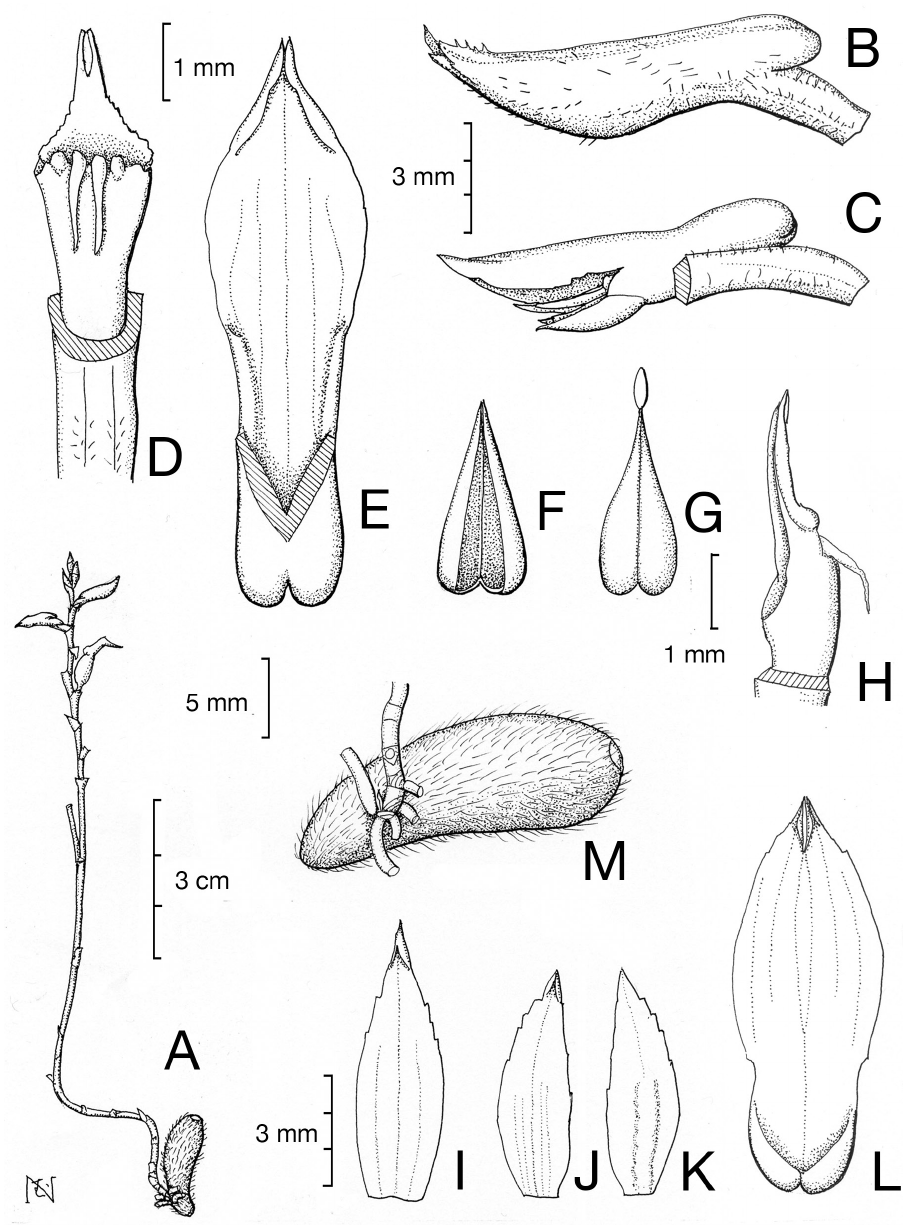
Figure 1. Drawing of Tropidia connata J.J.Wood & A.L.Lamb. A Gross morphology B Lateral view of unopened flower C Lateral view of the column with lip D Dorsal view of the column E Lip F Anther cap G Pollinia H Lateral view of the column I Dorsal sepal J, K Lateral petal of abaxial (J ) and adaxial ( K ) side. L Lateral sepal M Tuber with basal part of inflorescence with short filamentous roots. Scales 3 cm ( A ), 3 mm ( B, C, I–K ), 1 mm ( D–H ), 5 mm ( M ). Drawing by Ms. Mutsuko Nakajima based on the specimen